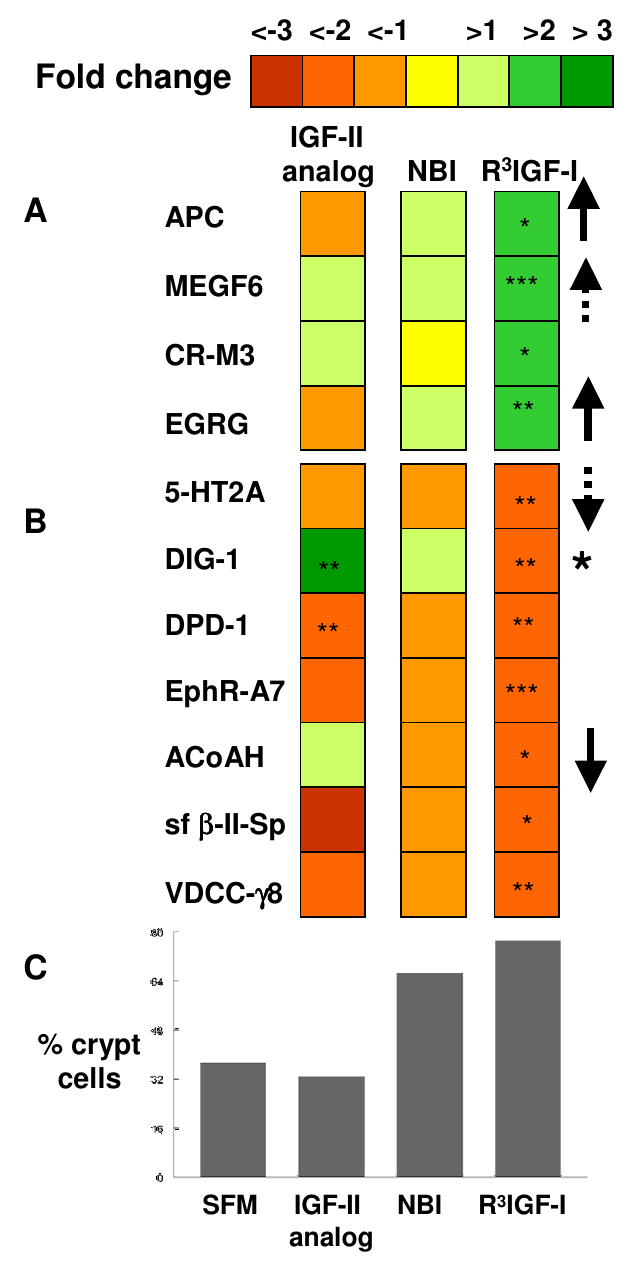
Figure 3 Gene array screen using skewed IEC-18 cell composition to find potential phenotypic markers. Affymetrix rat gene chips were used to compare RNA from SFM and R 3 -IGF-I treated cells to find individual genes with significant fold changes – defined as greater than two fold more (A) or two fold less (B) with a p-value of less than 0.1 for the purpose of this screen. These were then compared with the fold changes from IGF-II analog and NBI 31772 to look for fold change trends that paralleled the changing cell composition (summarized in C as the percentage of crypt cells). The results are presented as upward arrows (strong positive correlations), upward dashed arrows (weak positive correlations), downward arrows (strong inverse correla- tions) and downward dashed arrows (weak inverse correlations). The large asterisk points to an example where both direct receptor agonists resulted in a significant difference but NBI 31772 did not, suggesting a direct drug effect rather than an effect of cell composition – making this gene a less likely candidate. For smaller asterisks, *** = p < 0.01, ** = p < 0.05, and * = p <